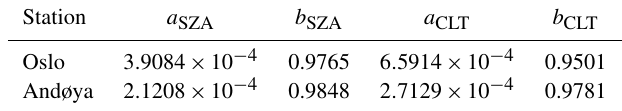
Table A1. Linear fit between DS / GI ratio and solar zenith angle (SZA) and cloud transmittance (CLT) used for the GI correction in Eq. (A6).